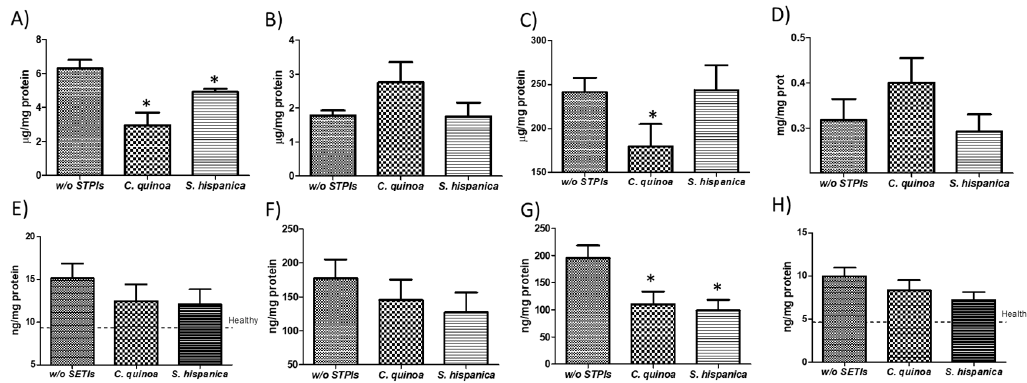
Figure 5. Hepatic concentration of low molecular weight thiols and cytokine profile in C57BL / 6 wild-type mouse livers at 8 weeks from the initial concurrent diethylnitrosamine (DEN)